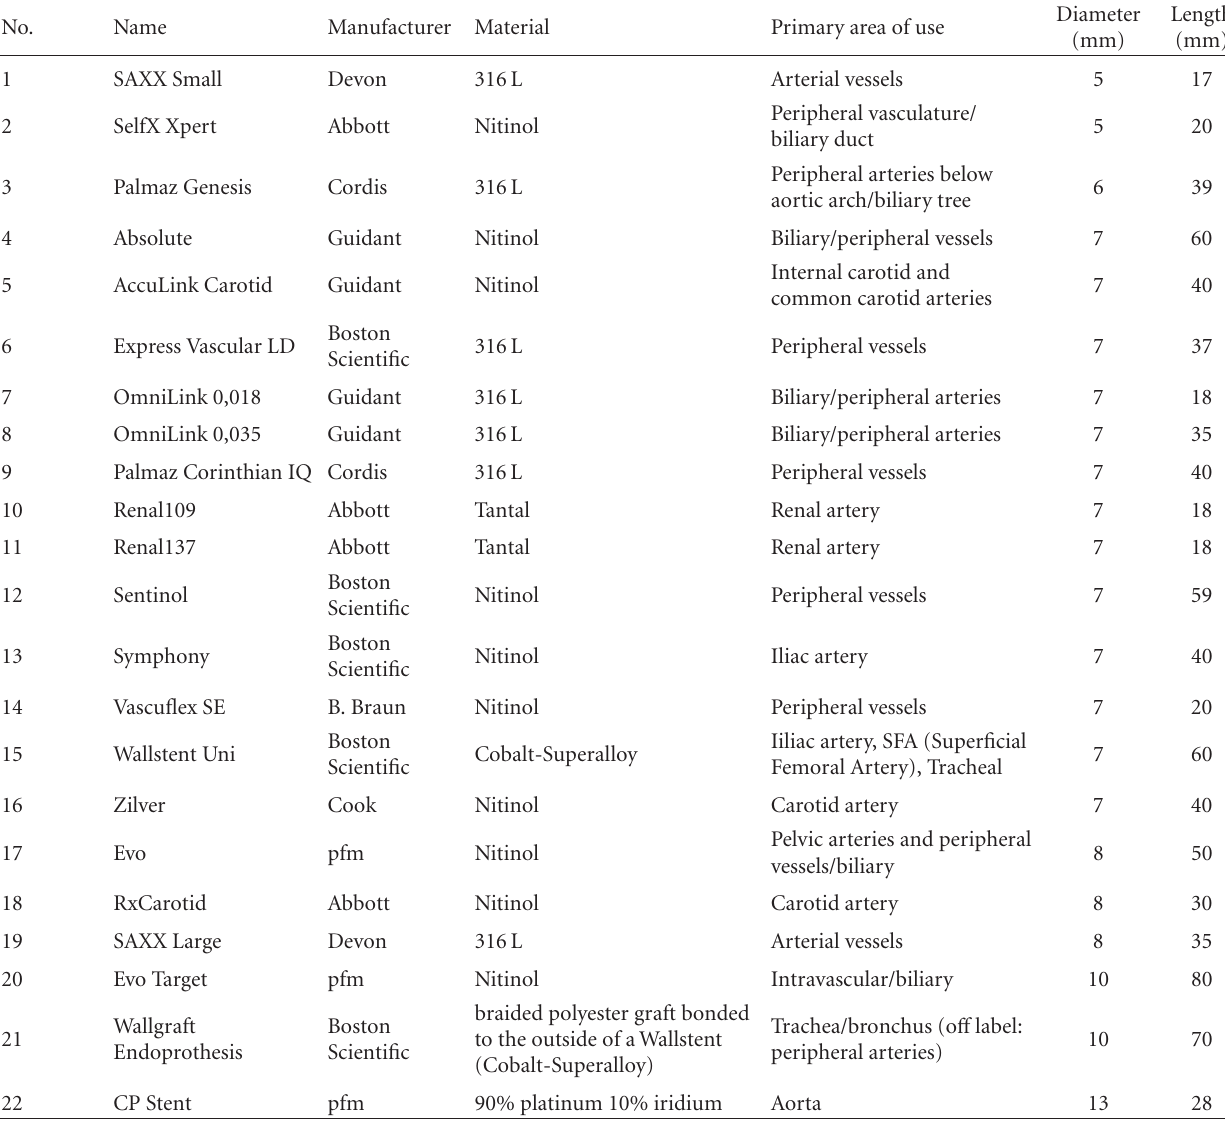
Table 1: Name, manufacturer, material, primary area of use, diameter, and length of the examined stents.